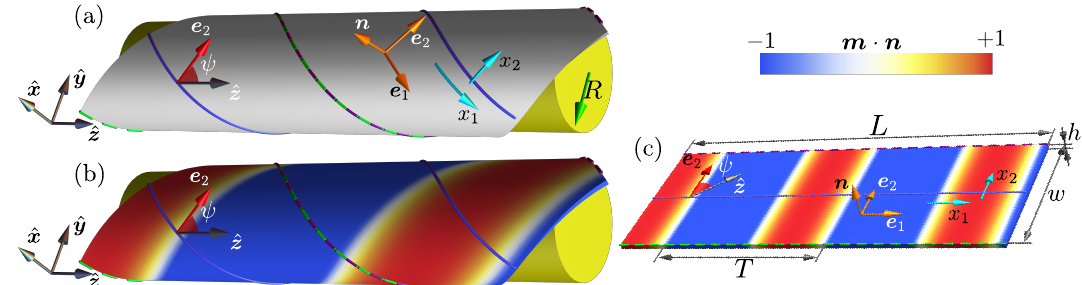
Figure 1: Schematic presentation of the geometry: (a),(b) The tubular shell is presented as a ribbon [ gray in (a) and colored surfaces in (b) ] of thickness h and width w which is tightly (without gaps) rolled up around the rod (yellow) of radius R ; (c) unrolled ribbon. Thick blue line ς ( x ,0 ) corresponds to the ribbon center, dashed 1 lines ς ( x , − w / 2 ) and ς ( x , w / 2 ) with w = 2 π R sin ψ correspond to the ribbon side 1 1 edges. Color scheme corresponds to the normal magnetization